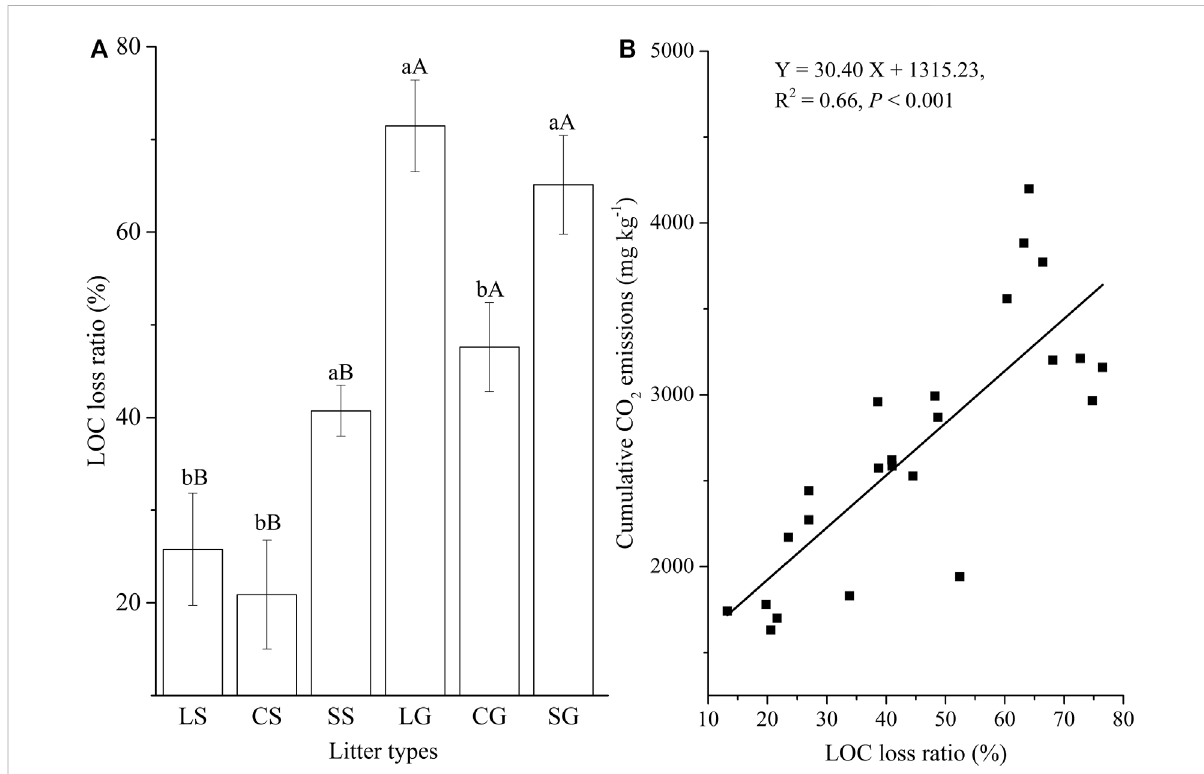
FIGURE 4 Loss ratio of labile organic carbon (LOC) (A) and its relationship with cumulative CO 2 emissions (B) . LS, CS, and SS represent standing litter of leaf, culm, and sheath. LG, CG, and SG represent leaf, culm, and sheath litter on the ground. Different lowercase letters represent signi fi